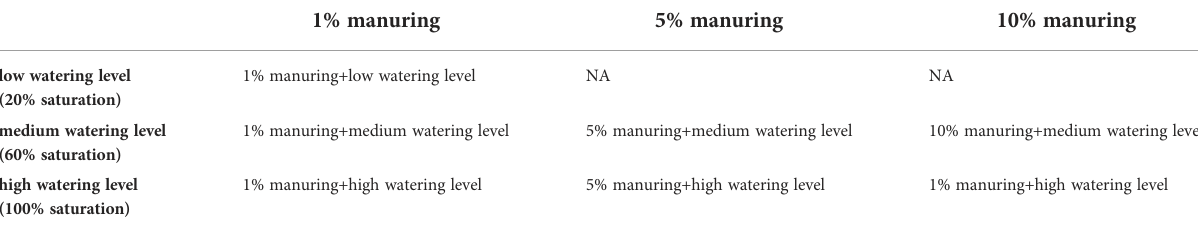
TABLE 1 Seven growing conditions offoxtail millet, broomcorn millet, and wheat at the greenhouse, Department of Plant Sciences, University of